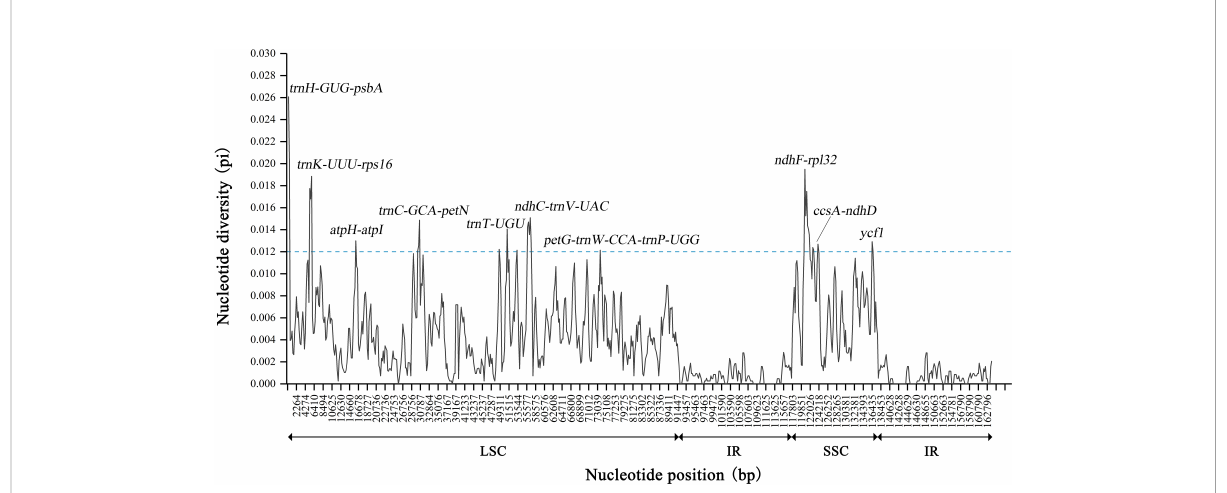
FIGURE 6 Nucleotide diversity of 13 Sabia chloroplast genomes. The X-axis represents the position of the chloroplast genome, and the Y-axis represents the nucleotide diversity of each